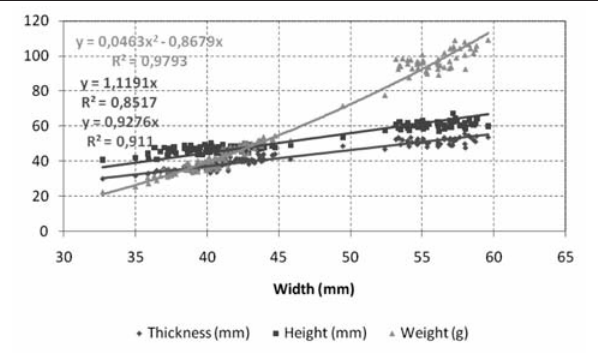
Fig. 34 :The connection of the measured data with the width for Late Jumbo apricot